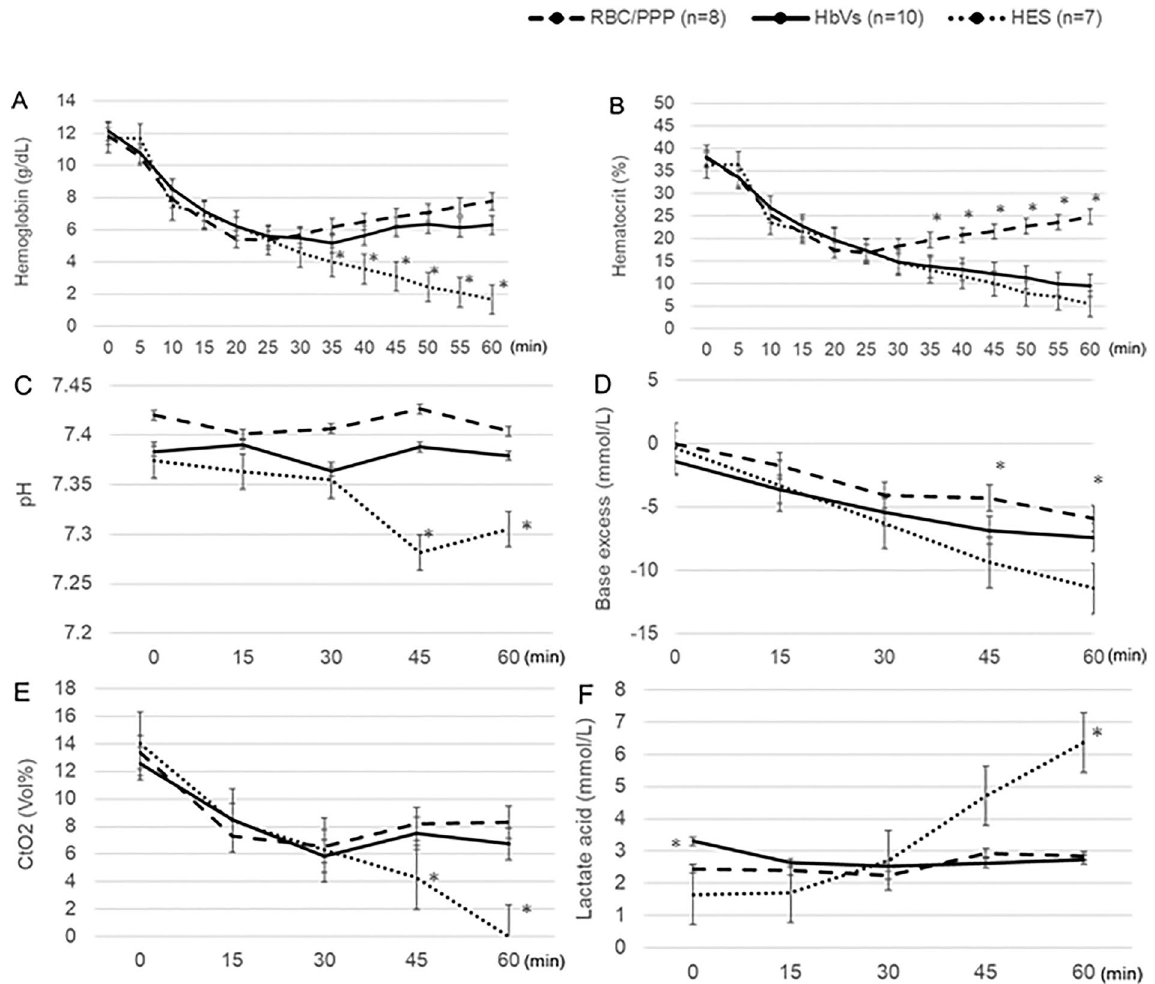
Figure 3. Changes in the levels of hematologic and blood gas variables. ( A ) At 60 min, the hemoglobin concentration is maintained over 6.0 g/dL in the RBC/PPP and HbV groups, whereas it decreases under 2.0 g/ dL in the HES group. ( B ) The hematocrit is similarly decreased in both the HbV and HES groups, unlike that in the RBC/PPP group. ( C ) The pH levels in the HES group are significantly lower than those in the other groups after 30 min. ( D ) The base excess levels at 45 and 60 min are significantly higher in the RBC/PPP group than in the other groups. ( E ) The CtO 2 level is decreased in all groups until 30 min; however, it is maintained above approximately 7.0 vol% beyond 30 min in the RBC/PPP and HbV groups. ( F ) At 60 min, the lactate acid levels are significantly higher in the HES group than in the other groups. *P < 0.05, value significantly different from the other groups. Data shown are the mean ± standard deviation. CtO 2 concentration of total oxygen, HbV hemoglobin vesicles, HES hydroxyethyl starch, RBC/PPP red blood cells with platelet-poor